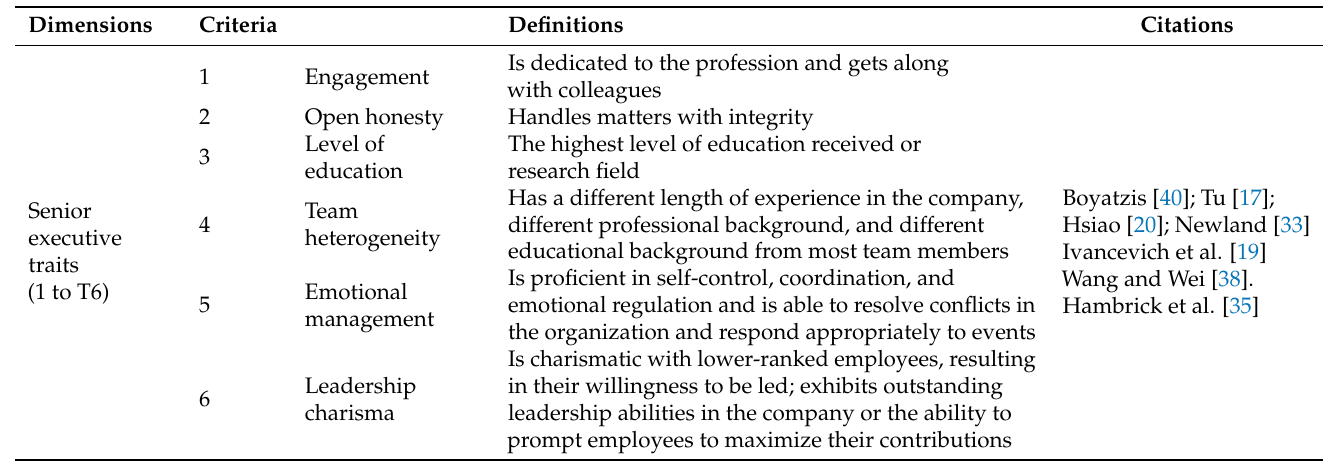
Table 6. Prototype dimensions and